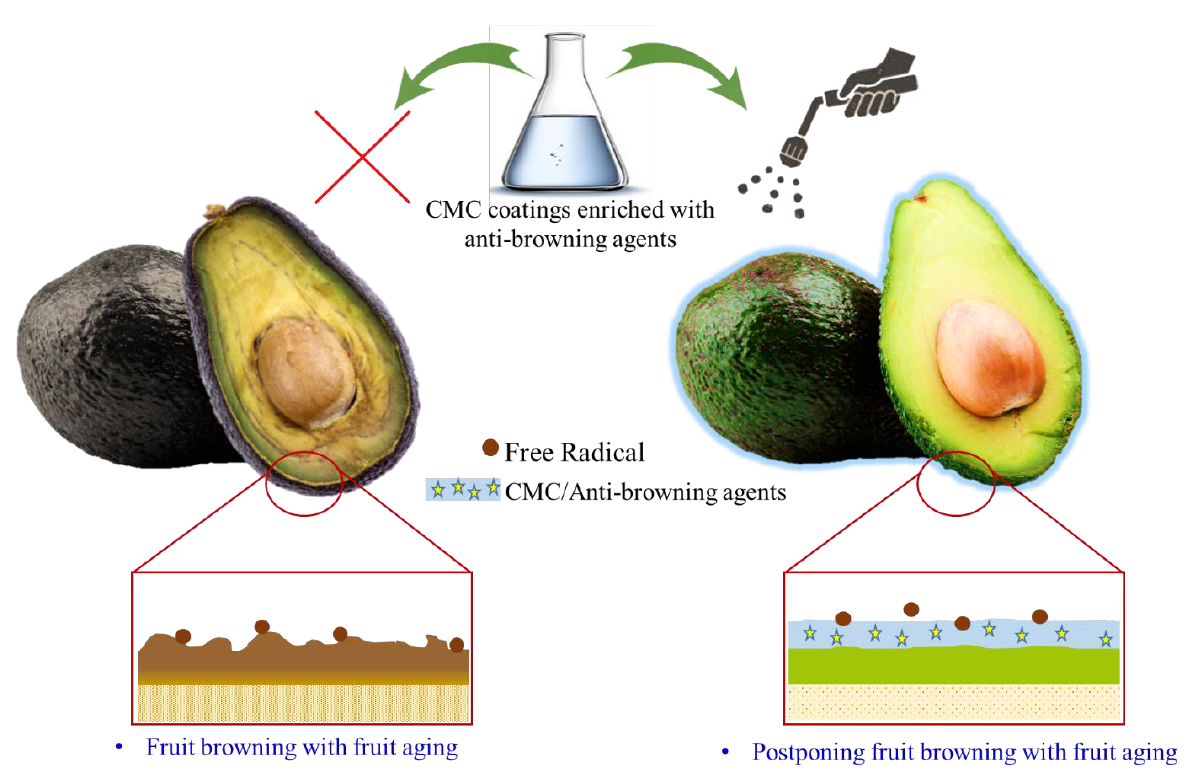
Figure 11. The use of edible active antibrowning coatings based on carboxymethyl cellulose (CMC).